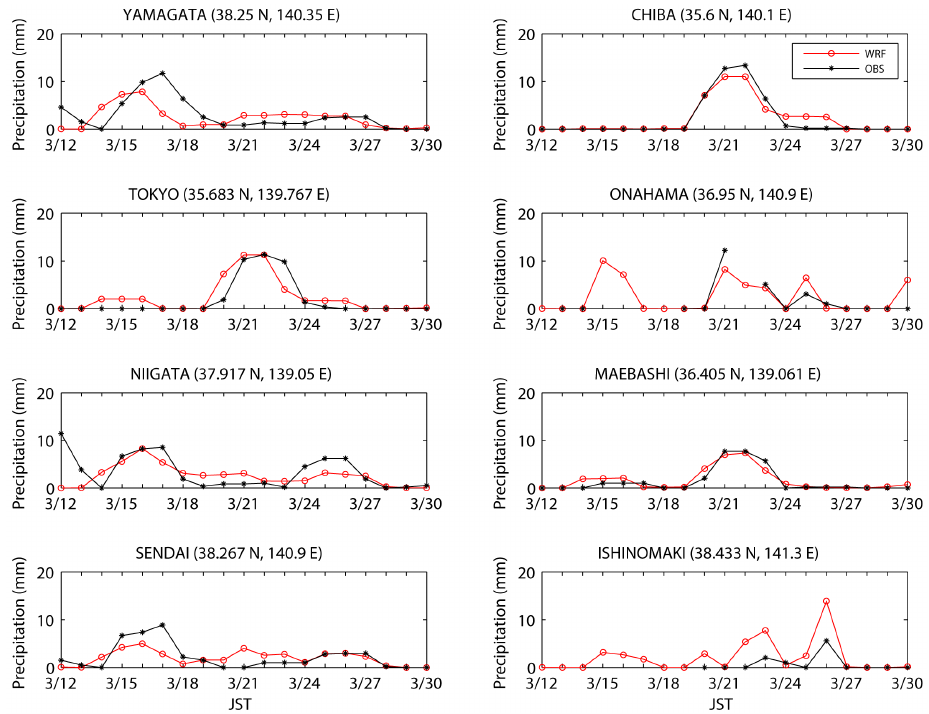
Figure 5. Simulated and observed daily precipitation at eight stations over Japan during the period from Japan standard time (JST = UTC + 9) 11 to 31 March 2011. Red circles represent the simulated data from WRF and the black asterisks represent the observed